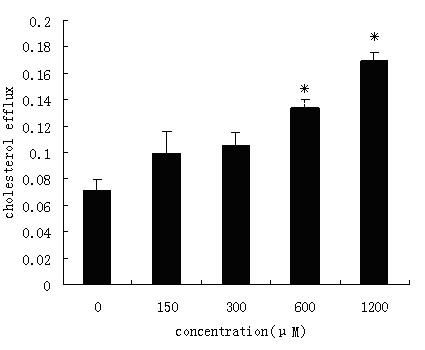
Effect of acetyl salicylic acid on cholesterol effluxes from foam cells. Monocyte-derived macrophages loaded with radio-labeled cholesterol were incubated for 24 h with RPMI containing 0, 150, 300, 600, 1200 μM ASA and 50 mg/L HDL. Intracellular and extracellular cholesterols were counted for their radioactivity by a scintillation counter. The decreases in the cellular contents of cholesterols caused by the ASA treatments at 600, 1200 μM were statistically significant (P < 0.05, ANOVA), whereas changes of those by ASA at 150, 300 μM are not significant (P > 0.05) between samples and the control. Results are expressed as mean ±S.D, of three experiments with duplicated samples. * P < 0.05,compared to control.